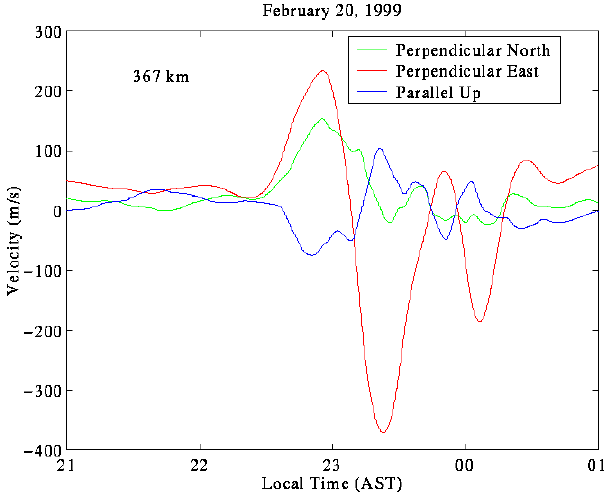
Fig. 4. Velocity components using the Sulzer et al. (2005). regular- ization at a height of